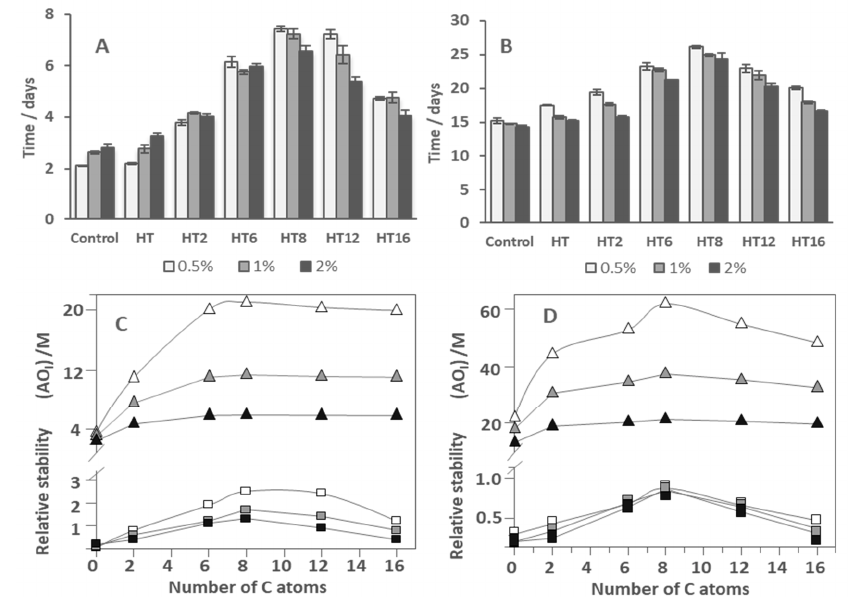
Figure 5. Effects of the AO chain length on the oxidative stability of fish oil 1:9 (O/W) nanoemulsions (( A ), [AO T ] = 0.125 mM) and 4:6 O/W emulsions (( B ), [AO T ] = 0.500 mM) prepared with Φ I = 0.005, (( A ), [AO T ] = 0.125 mM) and 4:6 O / W emulsions (( B ), [AO T ] = 0.500 mM) prepared with Φ I = 0.005, 0.01, and 0.02 in terms of the time required to reach an increase of 0.5% Δ CD with time. Comparison 0.01, and 0.02 in terms of the time required to reach an increase of 0.5% ∆ CD with time. Comparison between the antioxidant efficiency of AOs in 1:9 O/W nanoemulsions ( C ) and 4:6 O/W emulsions ( D ) between the antioxidant e ffi ciency of AOs in 1:9 O / W nanoemulsions ( C ) and 4:6 O / W emulsions ( D ) and the values of (AO) I in the same systems, at Φ I = 0.005, 0.01, and